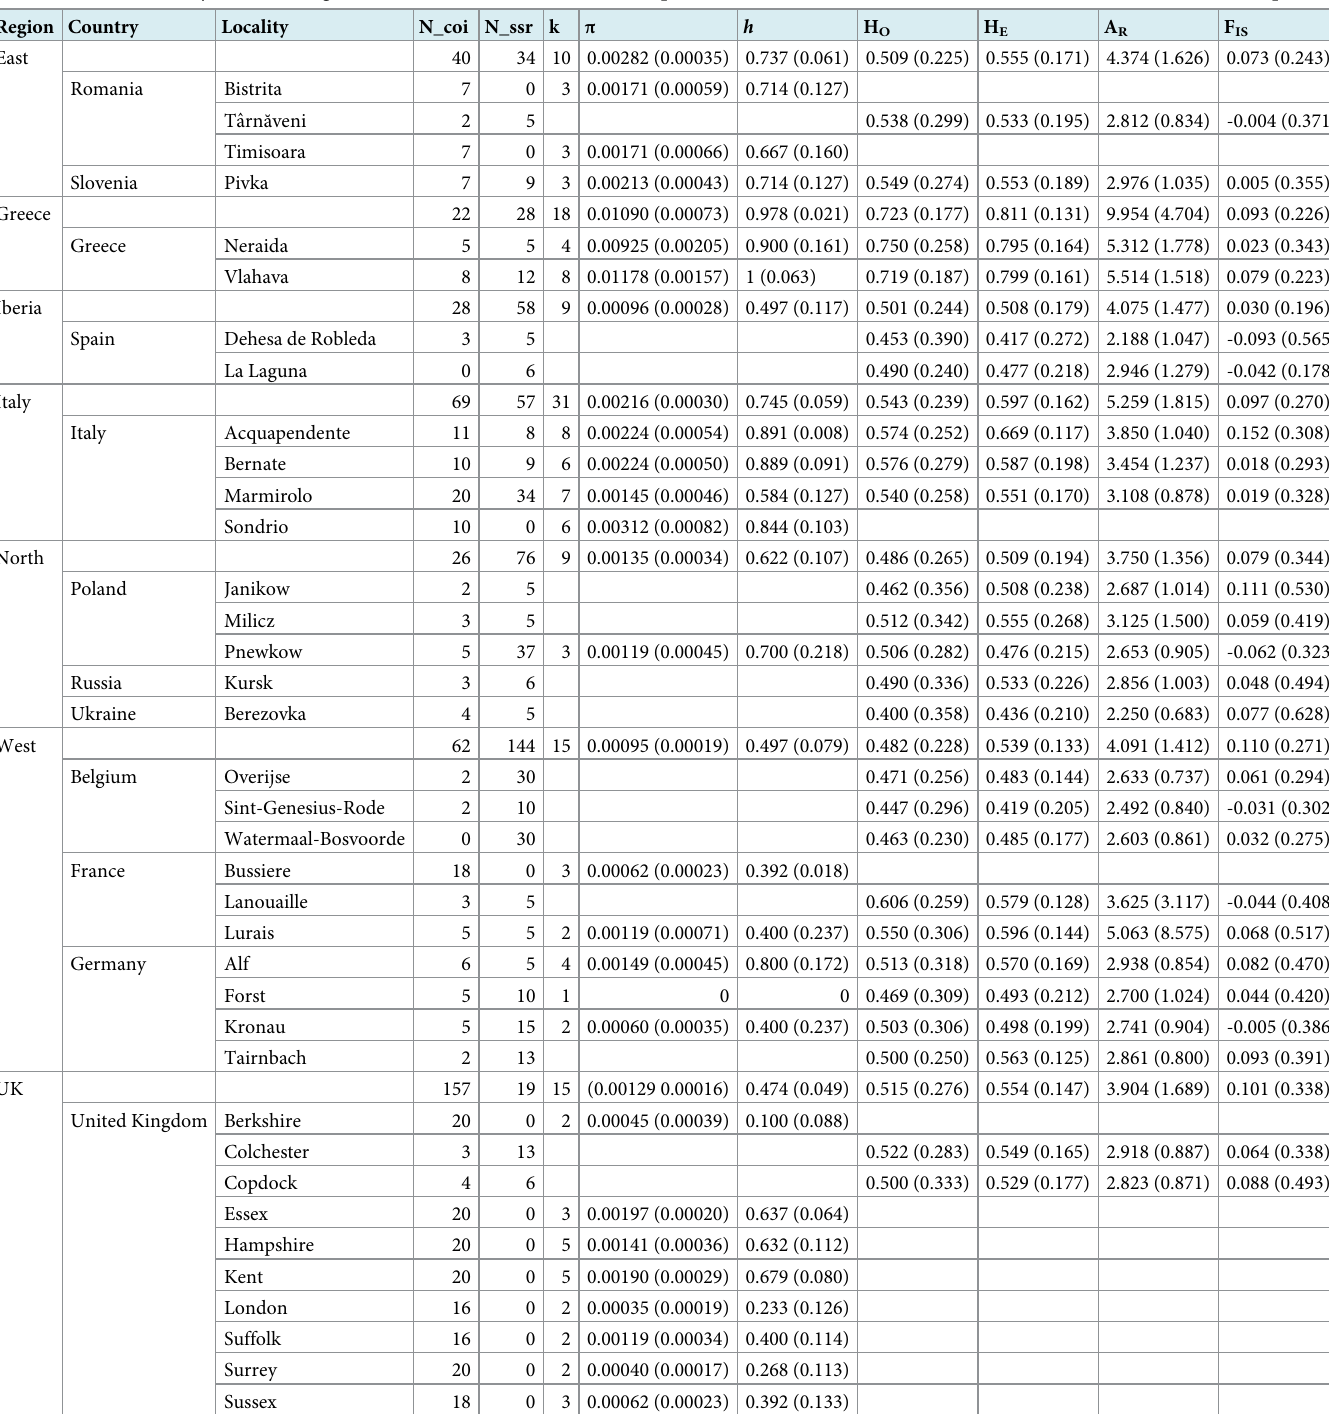
Table 1. Genetic diversity indices for regions and localities with a minimum sample size of five individuals at 16 microsatellite loci and/or based on COI sequences. Region